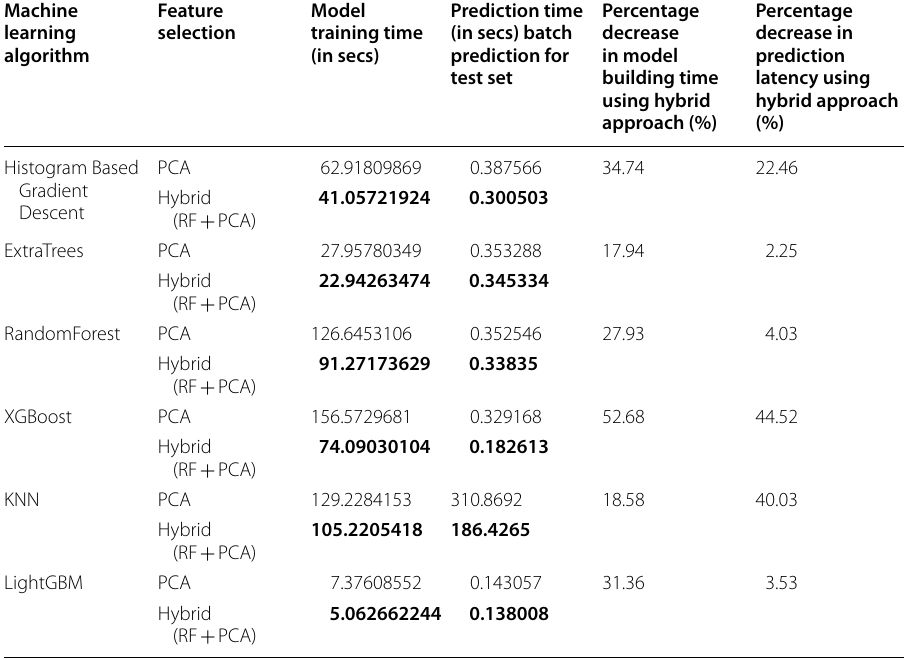
Table 8 Performance classification for the proposed Hybrid Feature Selection with tenfold validation